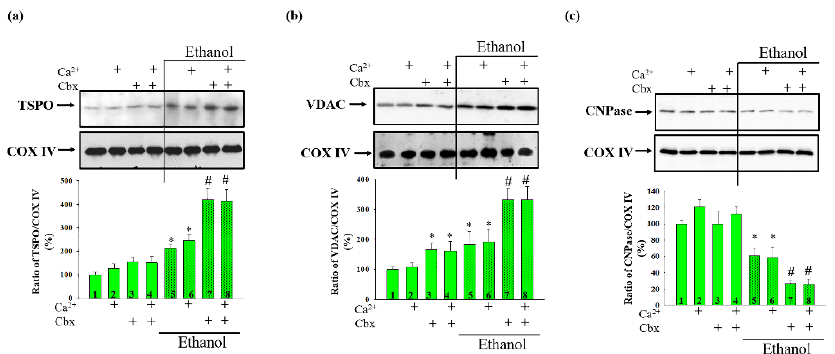
Figure 5. Effect of Cbx on the level of mitochondrial proteins—regulators of mPTP: TSPO—( a ), VDAC—( b ) and CNPase—( c ). The upper parts represent Western blots stained with the corresponding antibodies. Lower parts—quantitation of immunostaining using computer-assisted densitometry. The protein band intensity was quantified after normalization to COX IV. The values shown are the means ± SD from three independent experiments. The level of each protein in the Control RLM without additions was taken as 100%. * p ≤ 0.05 compared with the corresponding value in the Control RLM without Cbx additions with opened and closed mPTP, respectively (Columns 3, 5 vs. column 1 for the mPTP closed state and columns 4, 6 vs. 2 for the mPTP opened state), # p ≤ 0.05 compared with the corresponding value in the Ethanol RLM without Cbx additions (dotted columns 7 vs. 5 in closed mPTP and 8 vs. 6 in opened mPTP).